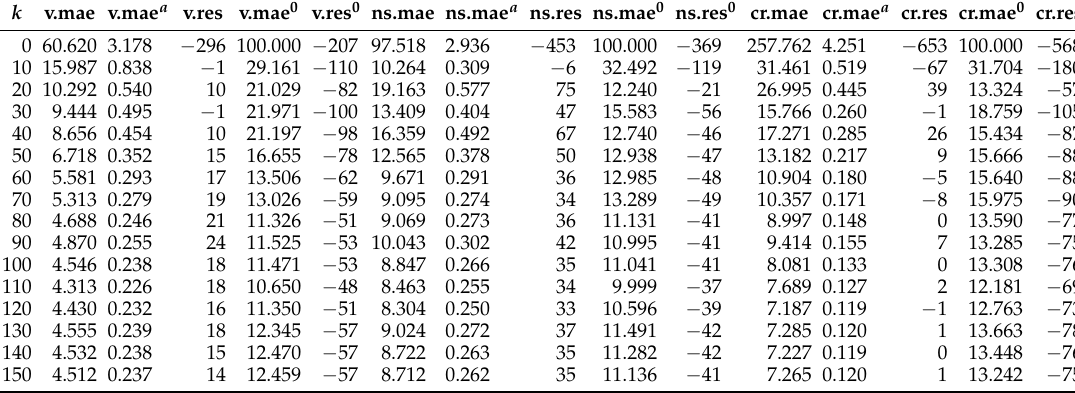
Table A5. Out-of-sample validation figures of the OLS proxy function of AC under 150–443 after each tenth